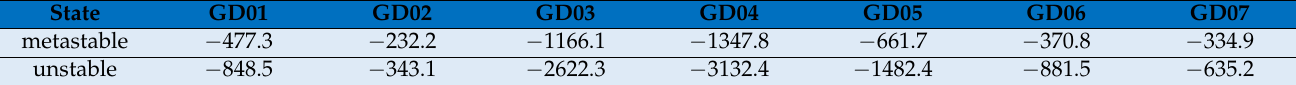
Table 6. July–September GNSS displacement monitoring sequence (unit/mm).